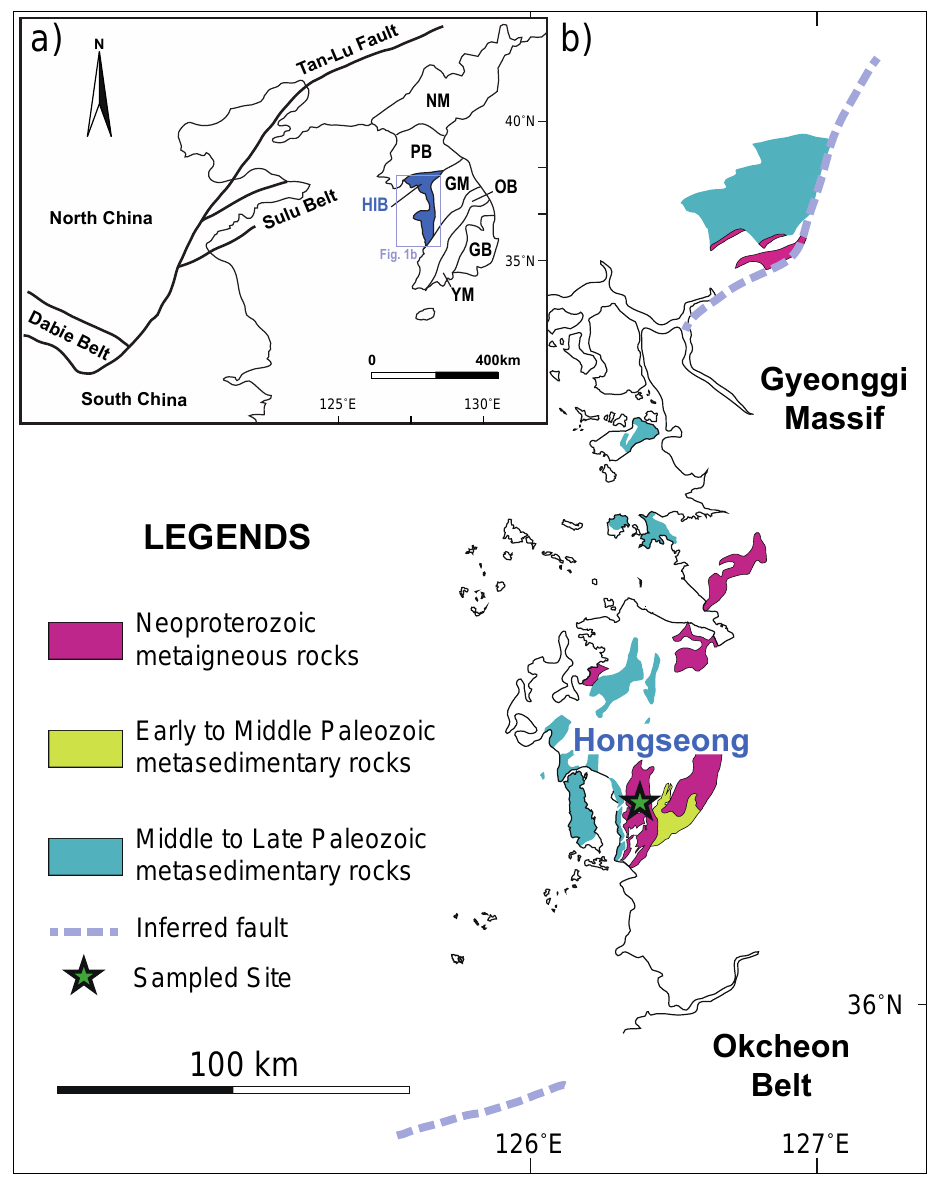
Figure 1. ( a ) Simplified tectonic map of East Asia. ( b ) Geologic map of the western part of the Korean Peninsula, showing the location of the lamprophyre dyke–marble contact zone (modified form [30] and references therein).